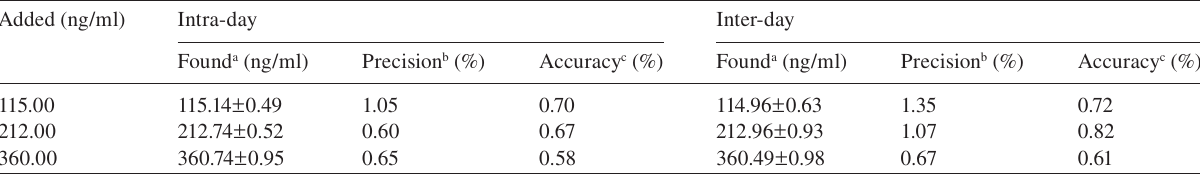
Table 3 Precision and accuracy of the DPAdSV method (n =